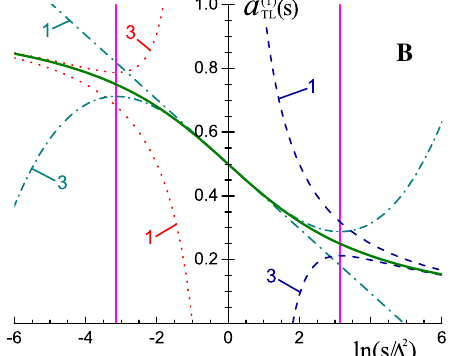
Fig. 3 Plot A: The one-loop “timelike” effective couplant a ( 1 ) [Eq. (17), solid curve] and the naive continuation of the one-loop per- turbative couplant into the timelike domain a curve]. Plot B: The one-loop “timelike” effective couplant a [Eq. (17), solid curve] and its re-expansions at various energy inter-